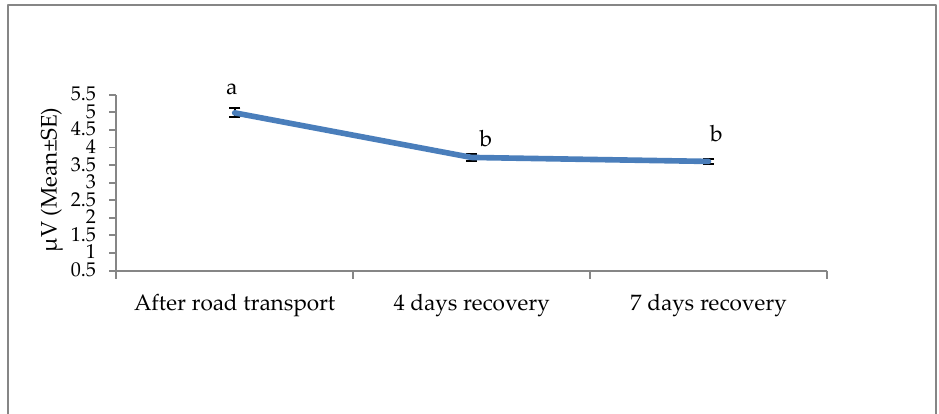
Figure 6. Effects of road transport on the delta root mean square (RMS) in cattle. The number of animals used in each sampling point was 24 heifers. Means with different letters are significantly different at p < 0.05.